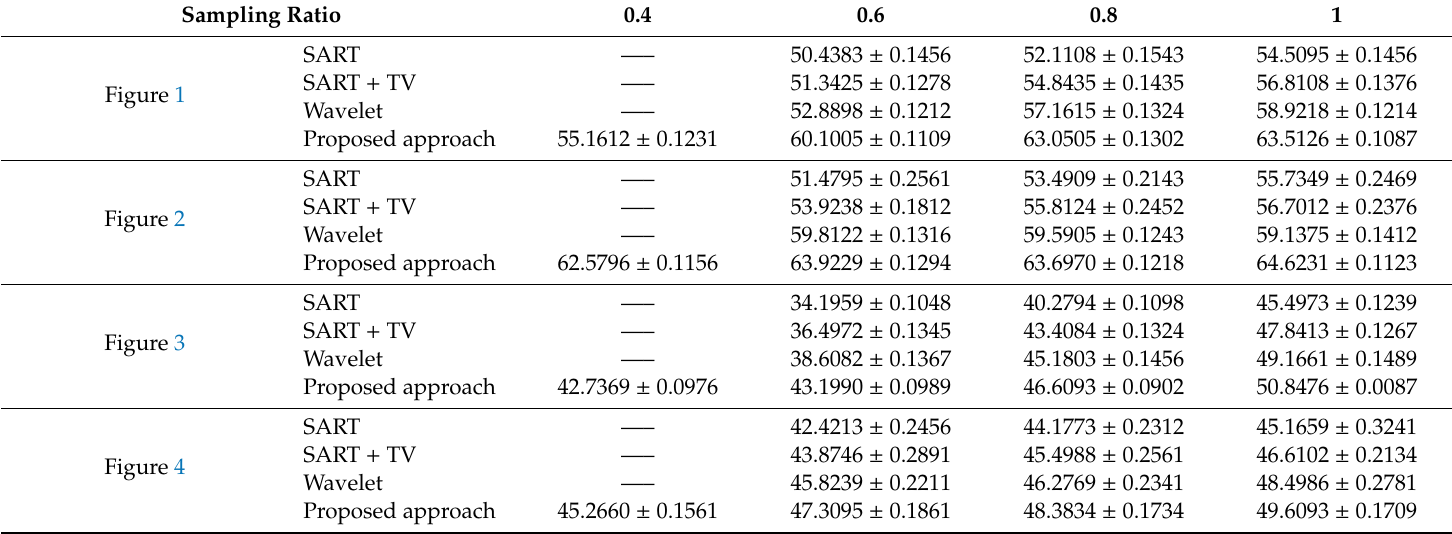
Table 2. Peak signal-to-noise ratio (PSNR) average performance comparison of the proposed algorithm with a series of algorithms, namely, SART [3], SART + TV [13], Patch + ordering Wavelet [14] (SNR = 40